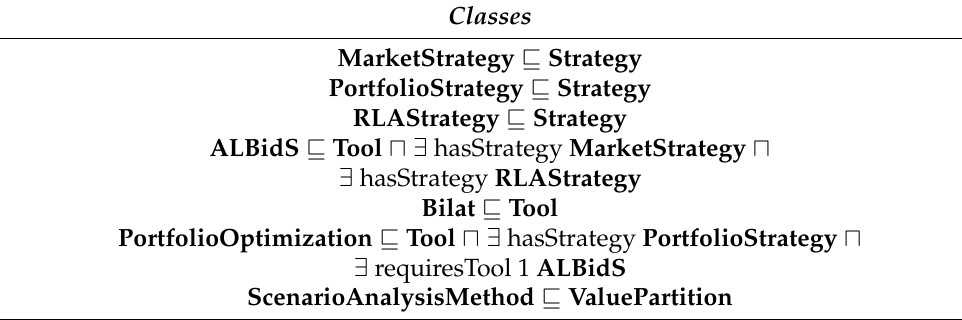
Table 4. AiD-EM Ontology sub-classes in DL